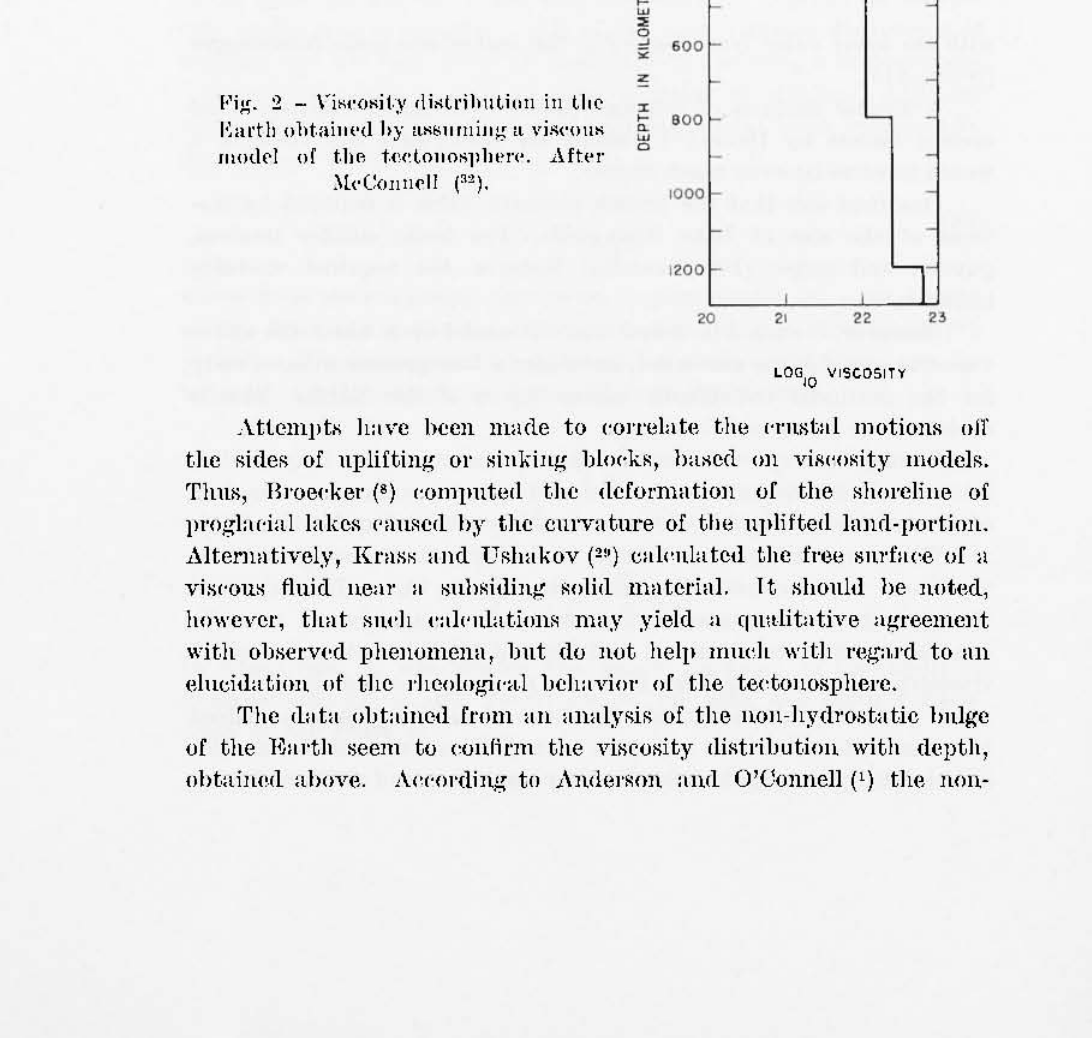
Caleulatiouf! of t.he ref!nlt in if!of!tatil' :ulju.~t.ment. :u;.~uming a variable vif!l'osity in the t.cl·tonosphere lwve alf!o heen m:ule by Danes(1S), Imt. his deppmlell('eH (exponent.ial amllinear) with dept.h are too simplc t.o have lllU(']\ l'l'Hl'tÌl'al sif{uifi(·<llu·e. The layered-vis('ouH model or iHoHtat.i(· l'f·hOlllld ('an hl' llla(le even more realistk by af!.~llmill.g' a thin ela.~tie layer on top.